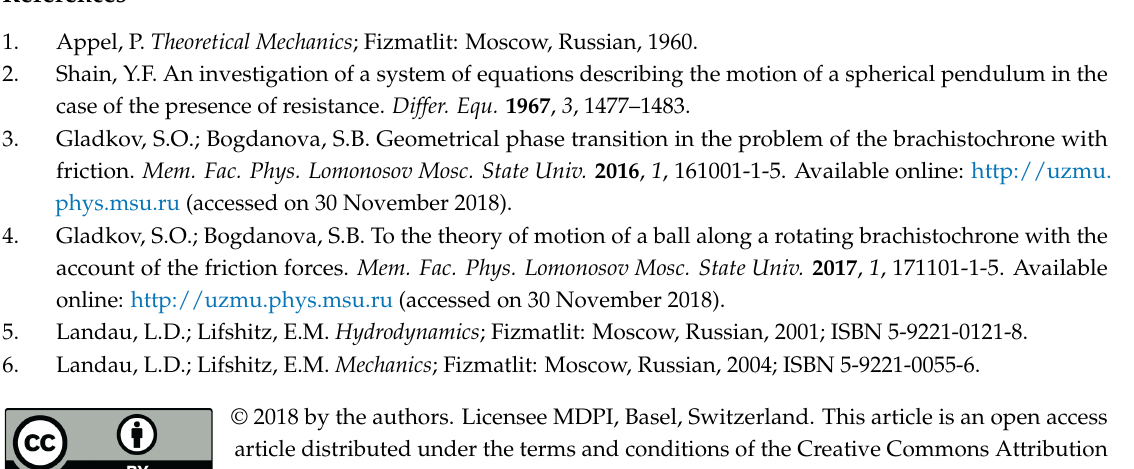
Figure 4. The projection of the three-dimensional trajectory of the ball, as illustrated in Figure 3, onto the x − y plane .